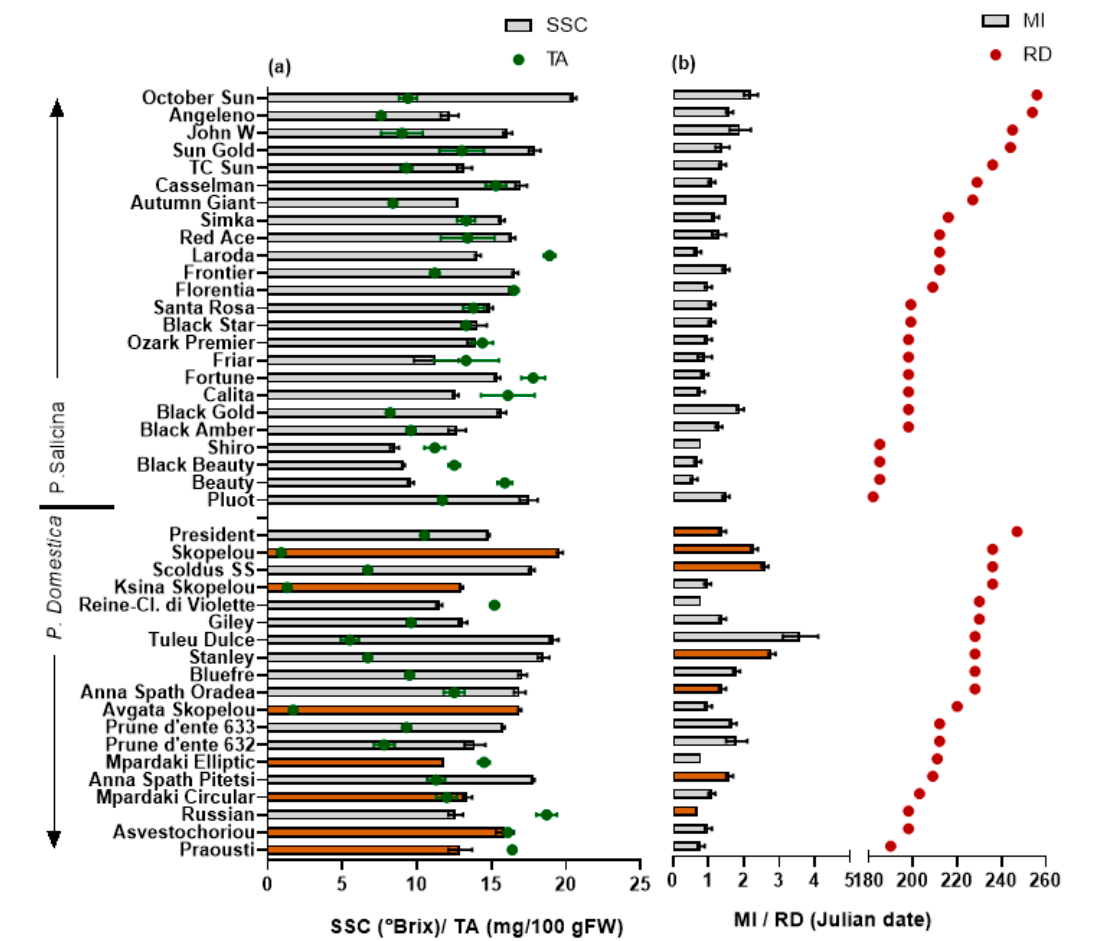
Figure 1. Mean (±SE) ( a ) soluble solid content (SSC, °Brix), titratable acidity (TA, mg citric acid/100 g FW), ( b ) maturity index (MI = SSC/TA), and ripening date (RD, Julian date) of 43 European and Japanese plums. Colored columns represent local cultivars. Least significant difference; SSC = 1.23, TA = 2.18, SSC/TA = 0.5.